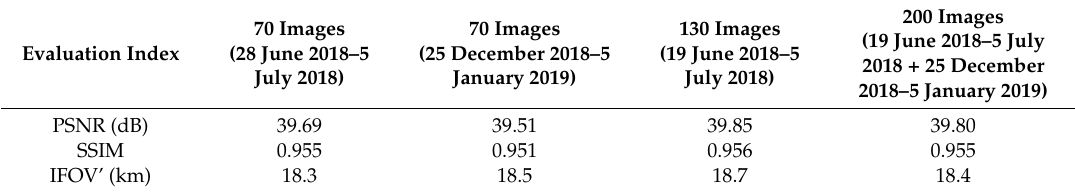
Table 3. The evaluation of deep residual CNN with different training